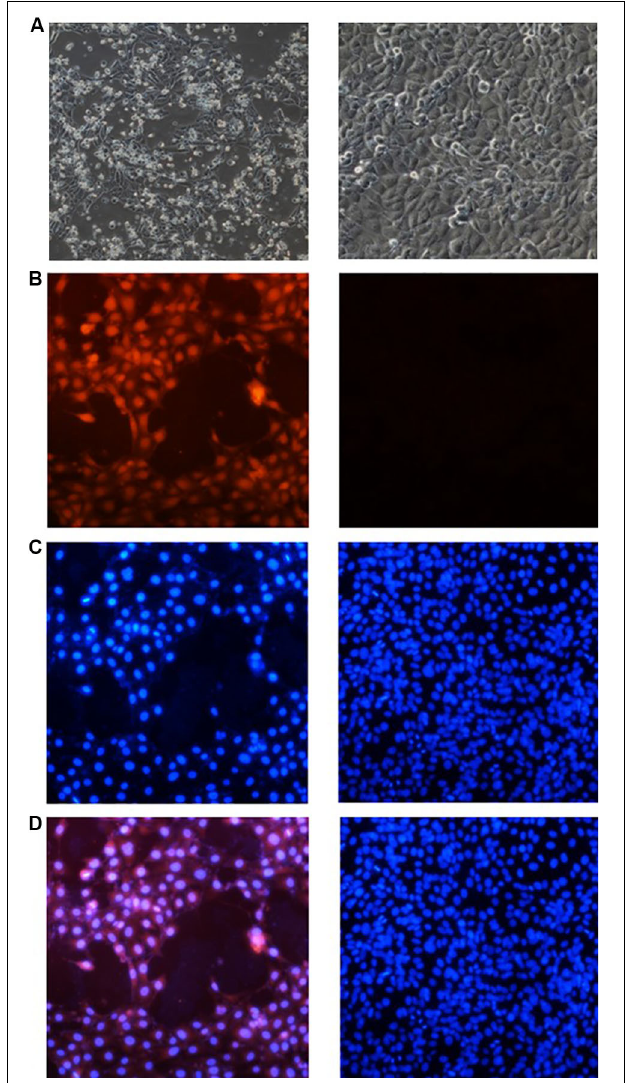
FIGURE 5 | Experimental results of cellular immunofluorescence. (A) The morphology of cell. Morphology of normal 3D4/21 cells is shown on the right, and that of the cells inoculated with the rescued PCV3 after 72 h is on the left. (B) Cell immunofluorescence of D17 mAb to delve into the PCV3 infection with 3D4/21 cells. The data of D17 mAb is represented on the left side and the detection of normal cell is on the right. (C) Nuclear staining results of 3D4/21 cells. The left side represents the nuclear staining pictures in the left of panel (B) , and the right side is the relevant one in the right. (D) Results of image superposition. The cell pictures in the corresponding position of panels (B,C) are superimposed. The cell pictures of panel (D) comply with the cell positions of panels (B,C) .